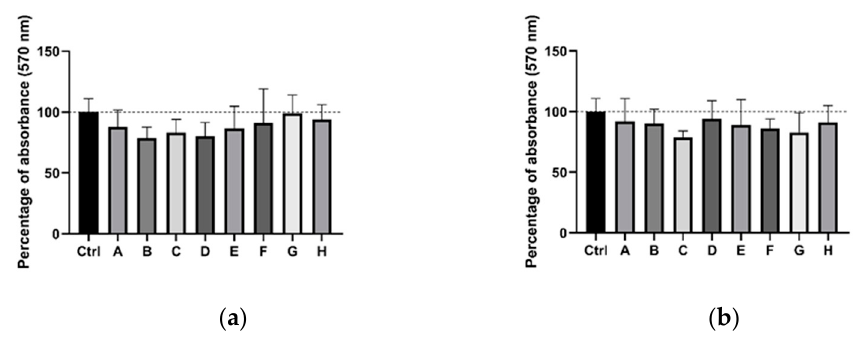
Figure 1. MTT assay results for 4T1 cells after 24 h of incubation with: ( a ) MN and; ( b ) MNOX. A-H represent different concentrations of MN and MNOX. Column A represents the highest concentration (4.5 mM Gd 3+ ) followed by fivefold serial dilution until the lowest concentration, represented by the H column. Data are displayed as a percentage of mean ( ± SD) absorbance (n = 4), 100% is the mean signal of untreated cells